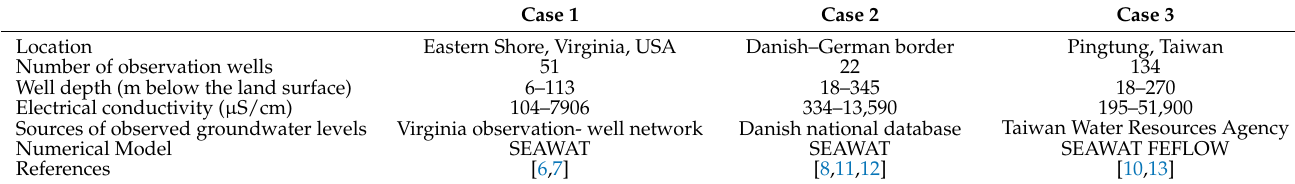
Table 1. Studies on the simulation of groundwater-level within saline aquifers.